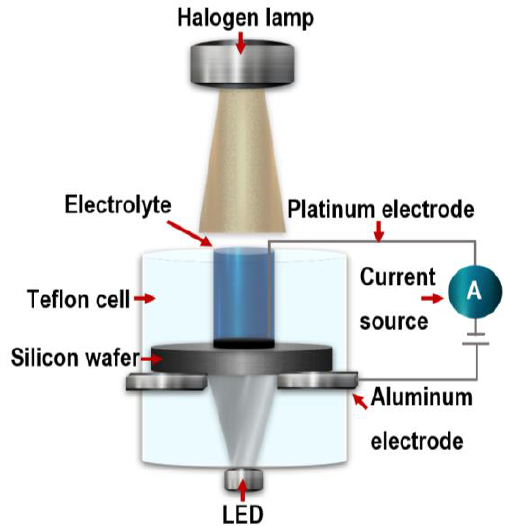
Figure 1. Schematic diagram of the electrochemical cell.